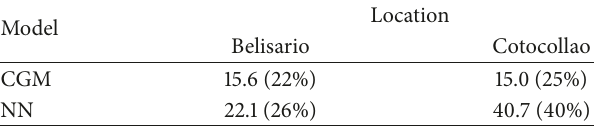
Table 8: MSE and MAPE of CGM and NN